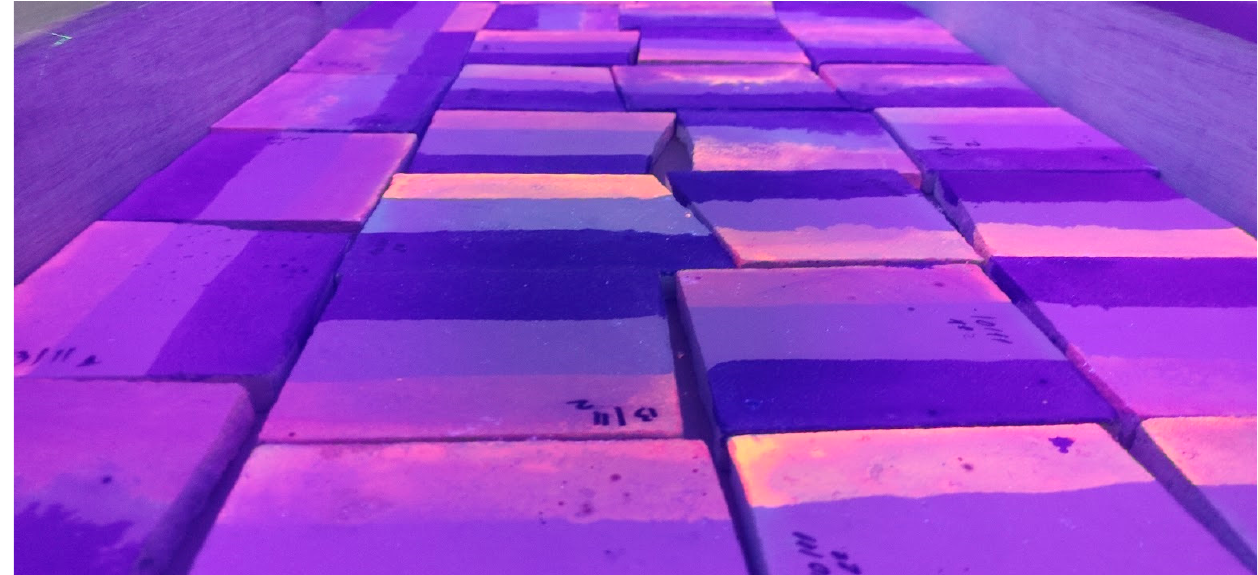
Figure 4. Tiles stained by rhodamine B and methylene blue exposed to UVA radiation.